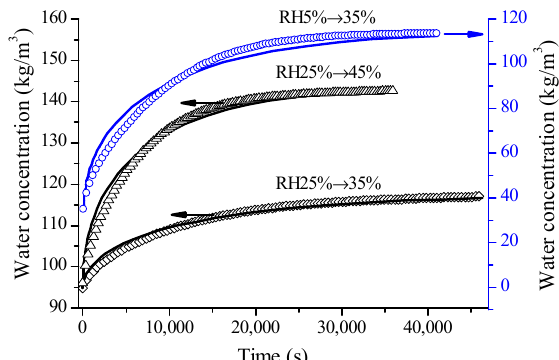
Figure 1. Water concentration evolutions of glutinous rice grains during the adsorptions of RH25% → 35%, RH 25% → 45% and RH5% → 35% (symbols) and their predictions according to Fick’s second law with their estimated di ff usivities (lines).